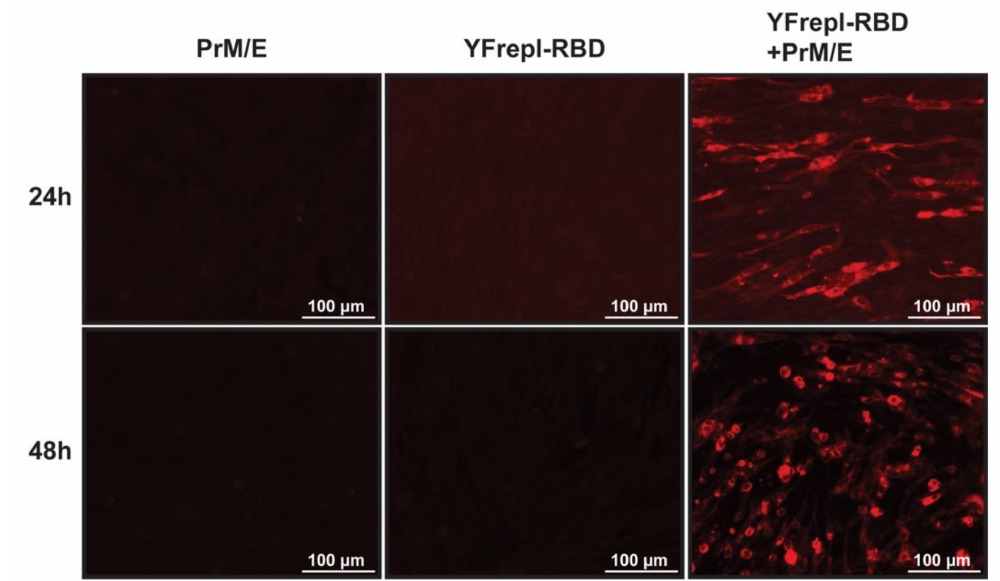
Figure 5. Expression of MERS-CoV RBD, following infection with replicon particles. Supernatants from BHK-21cells that were electroporated with either a plasmid encoding YFV prM/E, in vitro transcribed replicon RNA expressing the MERS-CoV RBD (YFrepl-RBD) or both, were harvested 24 or 48 h postelectroporation and used to infect fresh BHK-21 cells. After 24 h of incubation, the cells were fixated and analyzed by immunofluorescence microscopy. The RBD domain is stained in red. A 20 × objective was used to obtain the